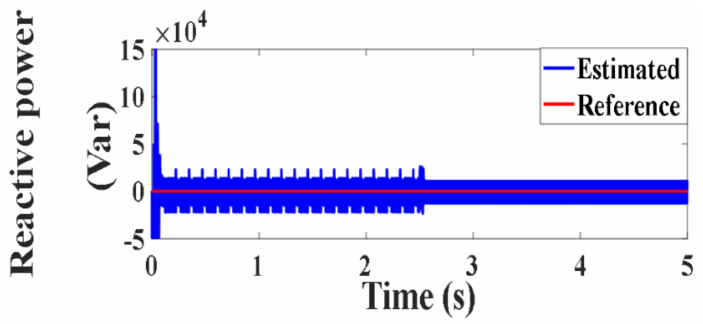
Figure 46. Reactive power under MPDTC (var).